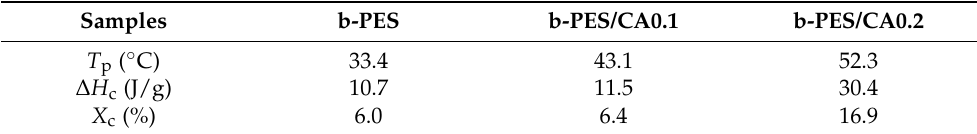
Table 1. Summary of some parameters of neat and nucleated b-PES during the cooling process.